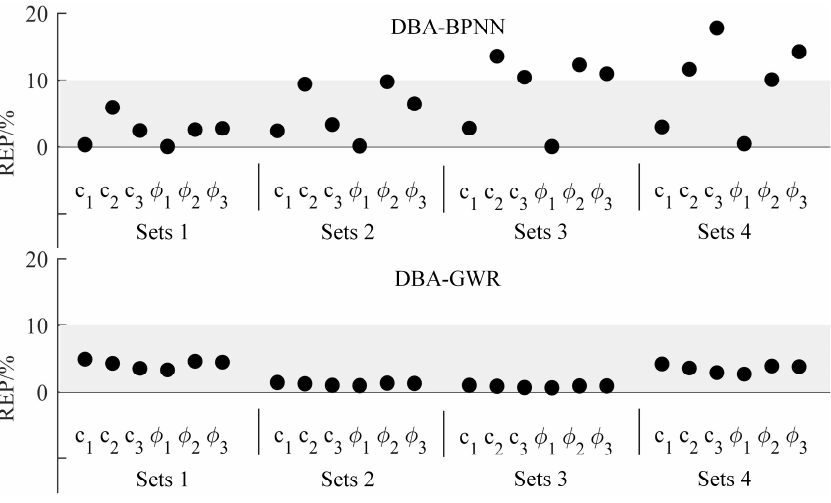
Figure 9. Accuracy of every inversion